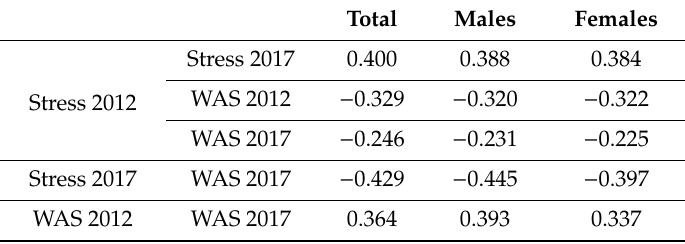
Table 2. Spearman correlations between stress and work ability variables in the mediation analysis for the years 2012 and 2017 for the total group and separate for males and females ( n = 1432, n = 575, n =